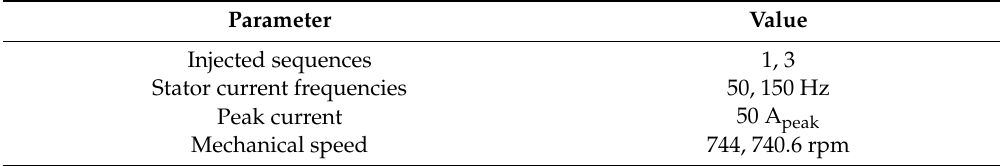
Table 5. Simulation parameters for the five-phase IM with tooth concentrated winding. Parameter